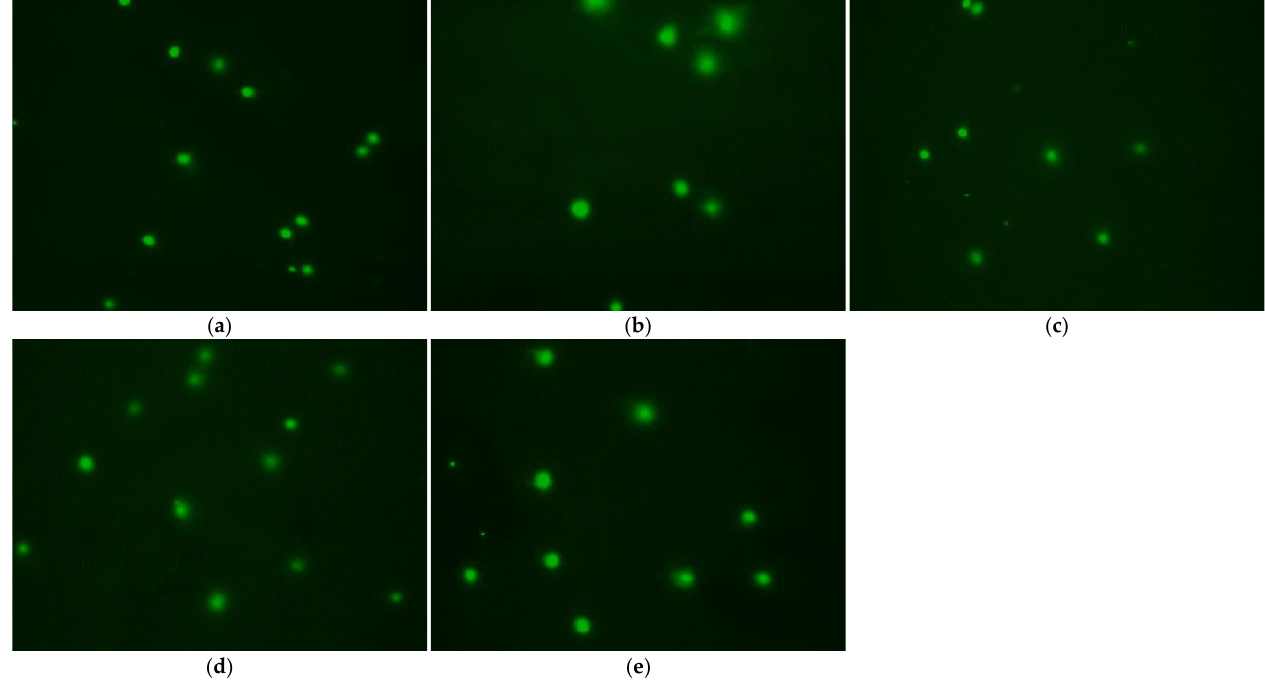
Figure 8. Fluorescent images of frozen and fresh sperm from roughscale sole, Clidoderma asperri- mum, using various concentrations of DMSO with Stein’s solution as the diluent. ( a ) Fresh sperm, ( b ) Cryopreserved sperm using 5% DMSO, ( c ) Cryopreserved sperm using 10% DMSO, ( d ) Cryopre- served sperm using 15% DMSO, ( e ) Cryopreserved sperm using 20%